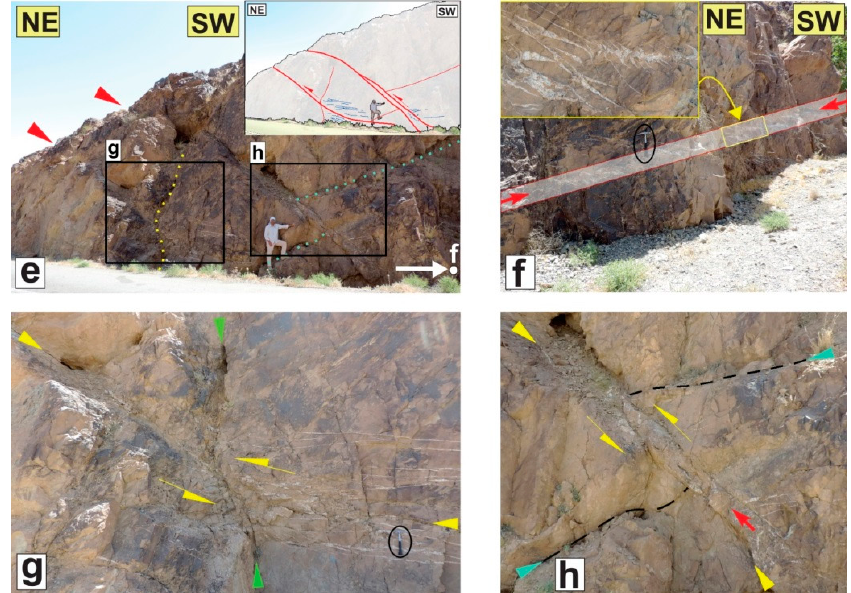
Figure 4. Structural evidence of the eastern parts of the South Birjand fault (see locations on Figure 1d). ( a ) The fault traces between the Paleocene flysch deposits and Quaternary gravel fans. ( b ) Close-up view of the fault plane with mean attitude of N70 ◦ W, 70 ◦ SW and its slicken lines (277 ◦ /32 ◦ ). ( c ) The youngest branches of the fault within the Quaternary deposits. ( d ) ~1 km left-lateral offset of the upper Cretaceous rock units along the southern branch of the fault. ( e ) The fault among the Paleocene flysch deposits that have displaced vertically rock blocks and minor fractures. ( f ) The sigmoidal veins indicate a nearly horizontal thrust shearing. ( g , h ) Close-up view of ~1 m reverse offsets along the fault plane.